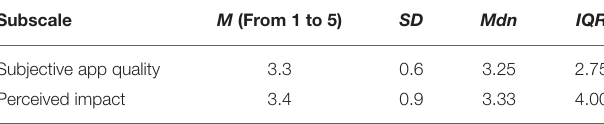
TABLE 2 | uMARS subjective quality score and perceived impact for Psixport. Subscale M (From 1 to